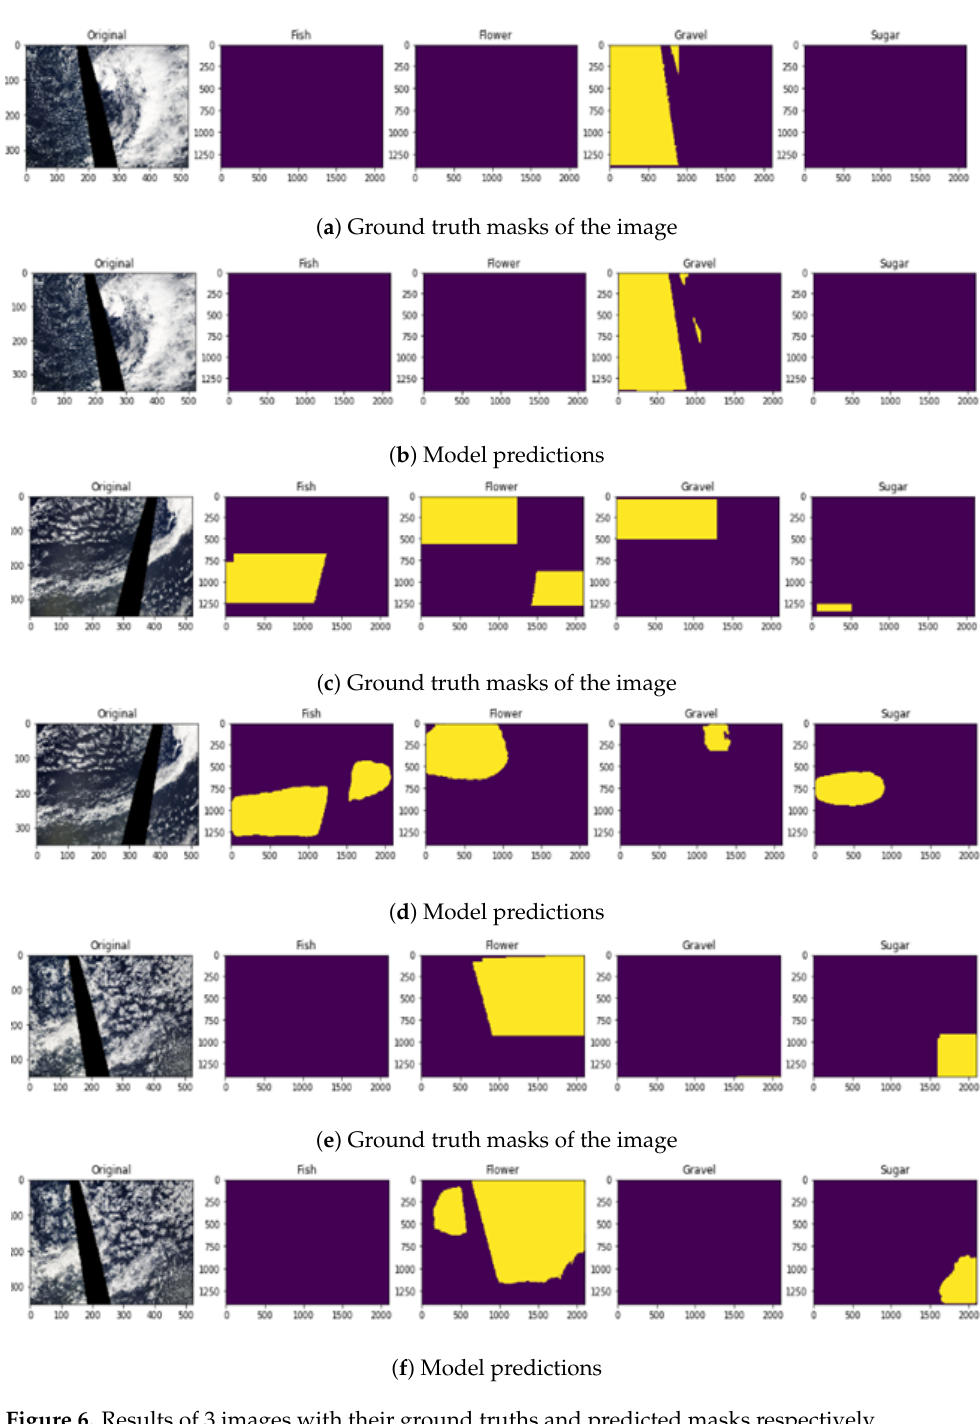
Figure 6. Results of 3 images with their ground truths and predicted masks